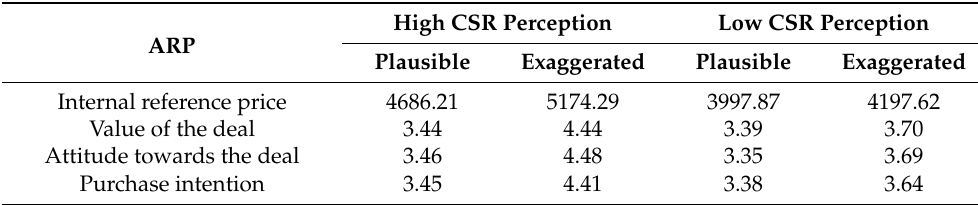
Table 1. Means of internal reference price, value of the deal, attitude towards the deal, and purchase intention.